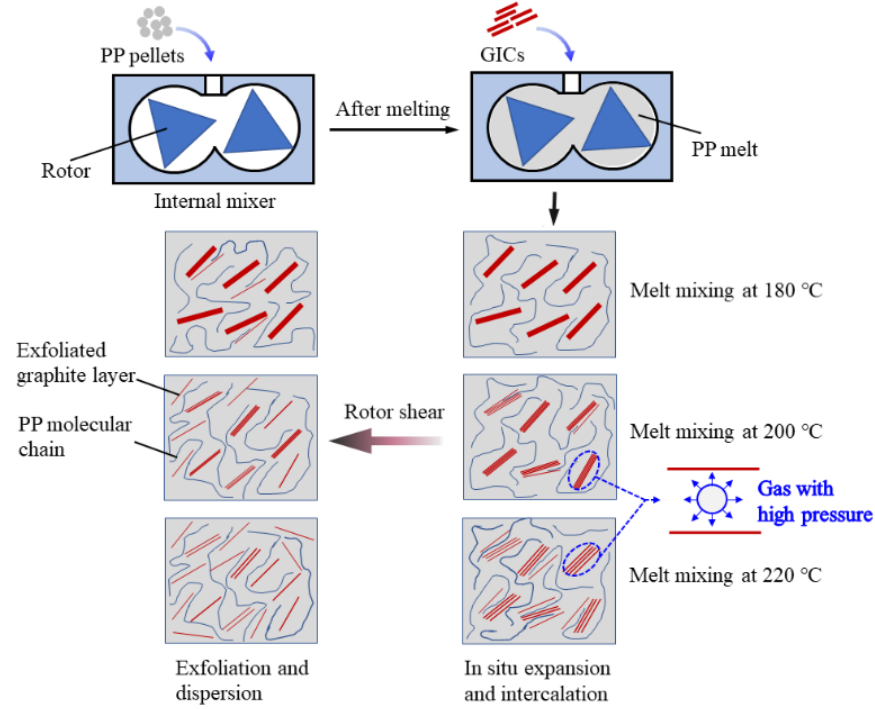
Figure 3. Schematics of underlying mechanism for in situ expansion, intercalation, exfoliation, and dispersion of GICs in PP matrix.